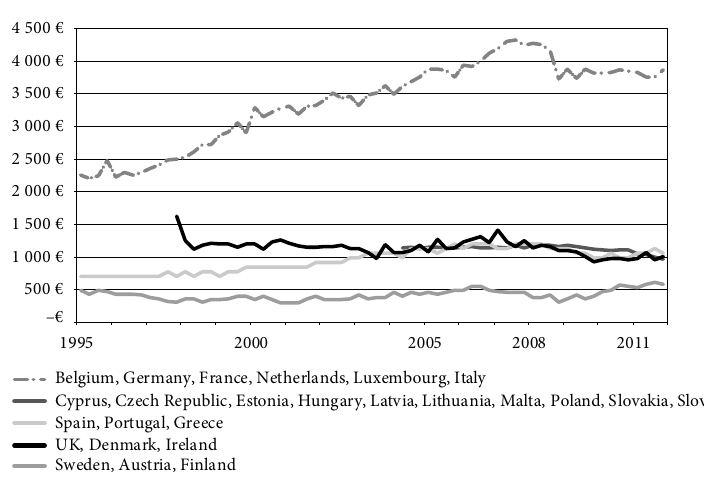
Fig. 1. Convergence within the groups of EU member states in terms of GDP per capita standard deviation Source : own